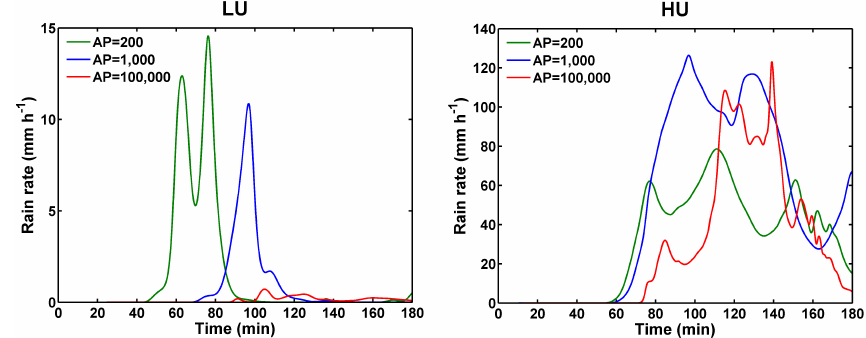
Figure 15. Time evolution of surface rain rates for the three aerosol episodes ( N CN = 200, 1000, and 100000cm − 3 , respectively) under LU (low updrafts, FF = 2000Wm − 2 ) and HU (high updrafts, FF = 50000Wm − 2 ) conditions.